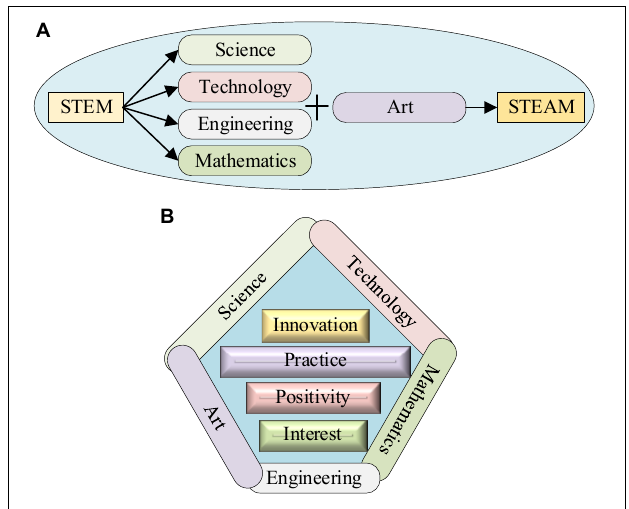
FIGURE 1 | The development form and comprehensive concept of the Science, Technology, Engineering, Art, and Mathematics (STEAM) teaching model (Panel A is the development form, Panel B is the comprehensive